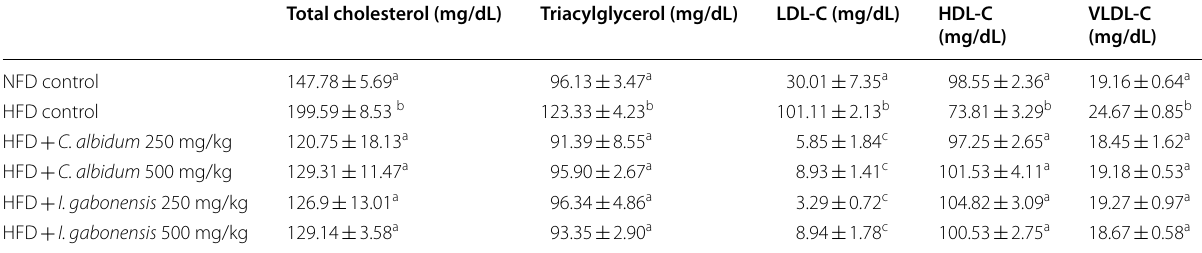
a, b, c These lower case letters a, b and c are different levels of significance at p < 0.05. a is significantly different from b and c, and vice versa. b is also significantly different from c and vice versa. The use of such alphabets is to show the homogenous sets which would bear same alphabet so that the different sets can easily be identified Data are expressed as mean SEM ( n 6). Values in the same column with different superscripts are significantly different ( p < 0.05) from each other ± = Table 2 Effect of C. albidum and I. gabonensis extracts on GSH, MDA levels and glutathione GPx activities of rat liver and heart homogenates